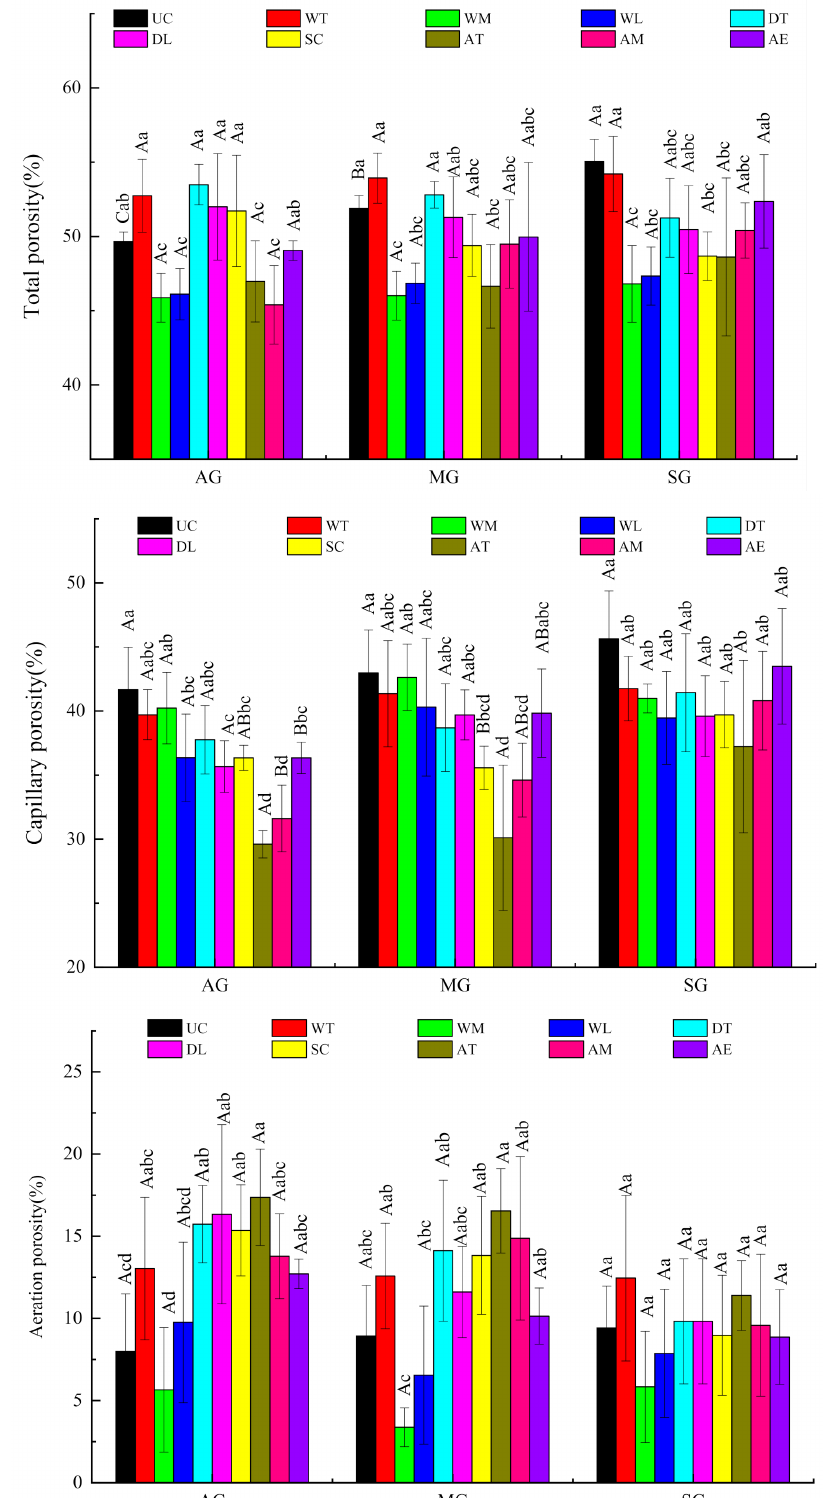
Figure 4. The content of total porosity, capillary porosity and aeration porosity in the different spatial positions in different stages of Benggang